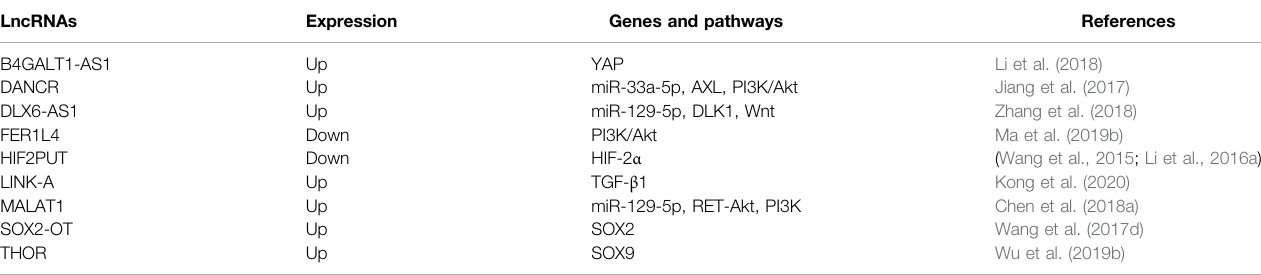
TABLE 2 | LncRNAs regulate CSCs in